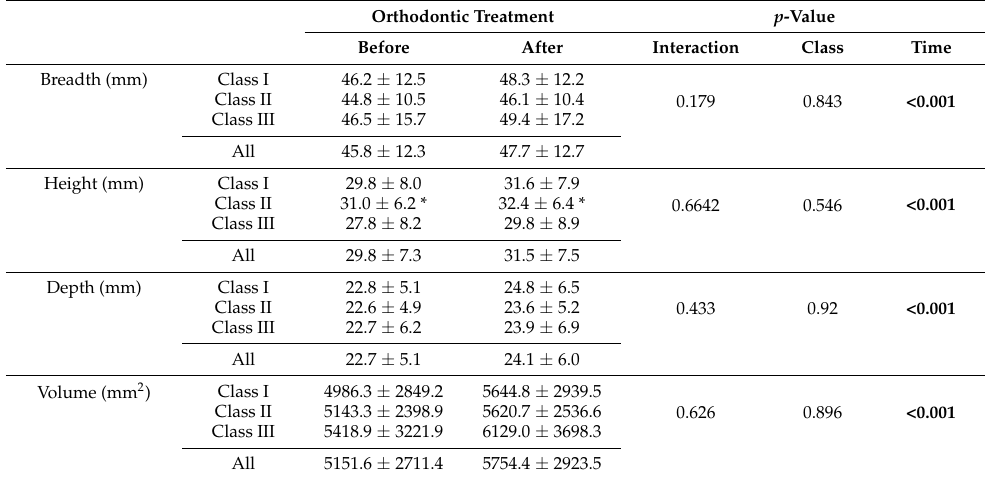
Table 3. The frontal sinus size and volume for each subgroup before and after orthodontic treatment.